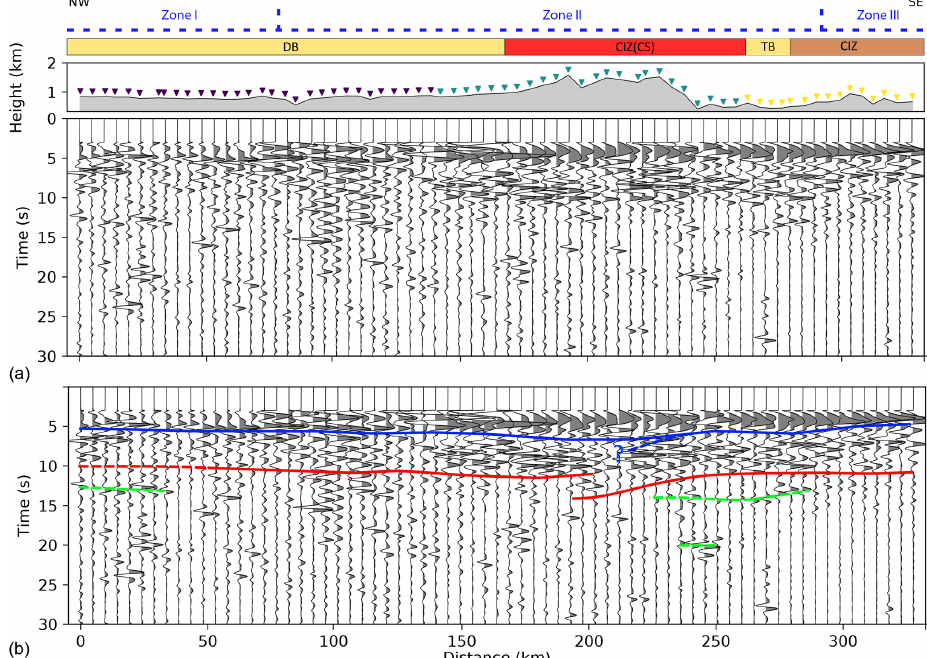
Figure 5. (a) Reflectivity profile retrieved by global-phase seismic interferometry. In the wiggle plot, the grey lobes indicate positive polarity. On top is the extent of the geological areas crossed by the profile and the boundaries of the granitic magmatism. Coloured triangles represent the different acquisition stages (from north to south: third, first, and second deployments). (b) Interpretation of the lithospheric reflectivity profile. Solid lines mark stable features, and dashed lines indicate possible features. The blue line marks the boundary between the upper crust and the mid-lower crust. The red line is the crust–mantle boundary. Scattered reflectivity within the upper mantle is marked by the dashed green